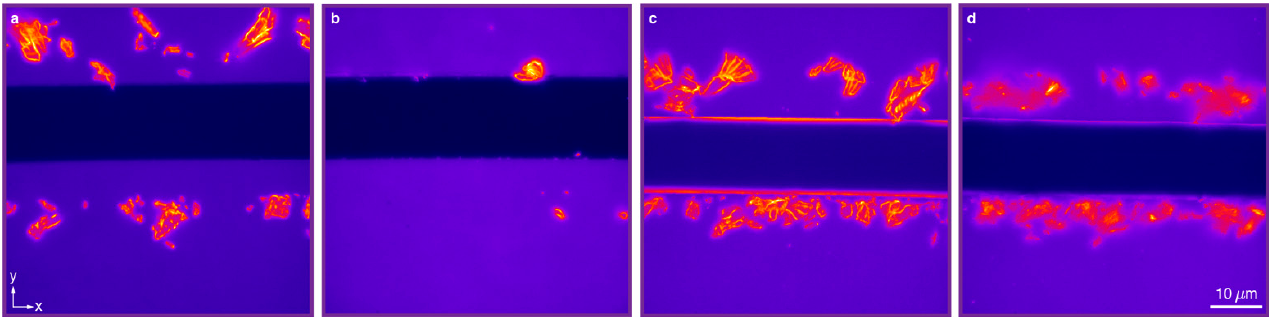
Figure 6. Overview of the fabricated samples. Fluorescence microscopy images of layered spherical SNPs with approximately one ( a ), three ( b ), eleven ( c , d ) layers deposited on top of a glass substrate, with embedding medium air ( a – c ) or an index matching fluid ( d ).